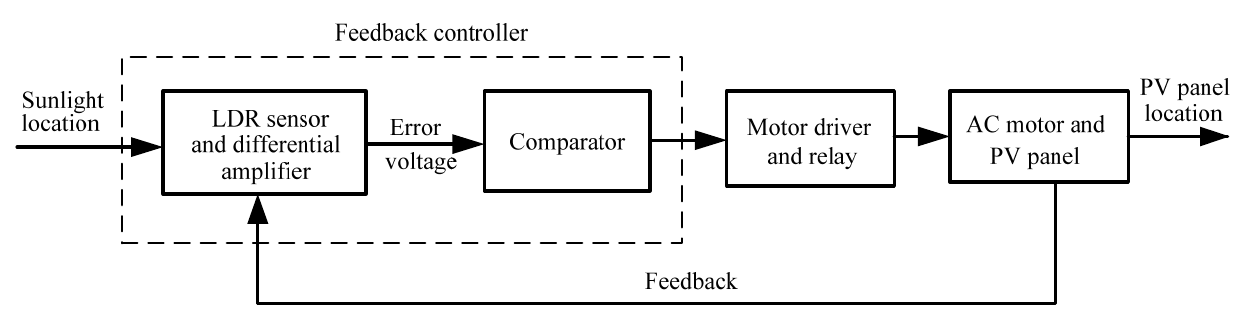
Figure 1. Block diagram of the solar tracking